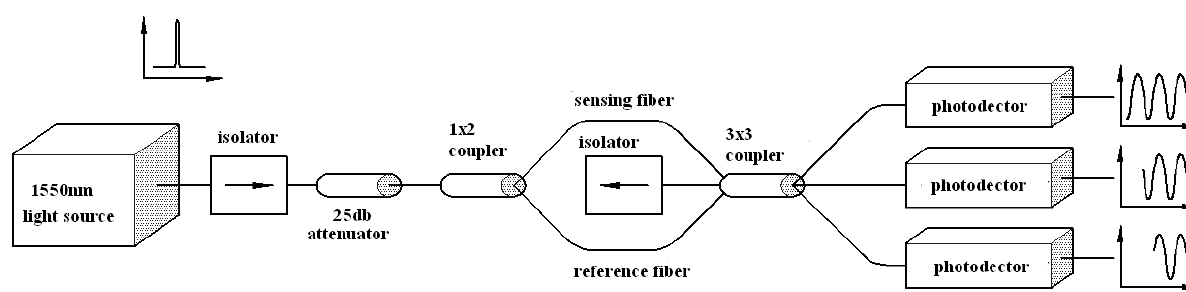
Figure 2. Schematic diagram of the Mach-Zehnder interferometric optical fiber